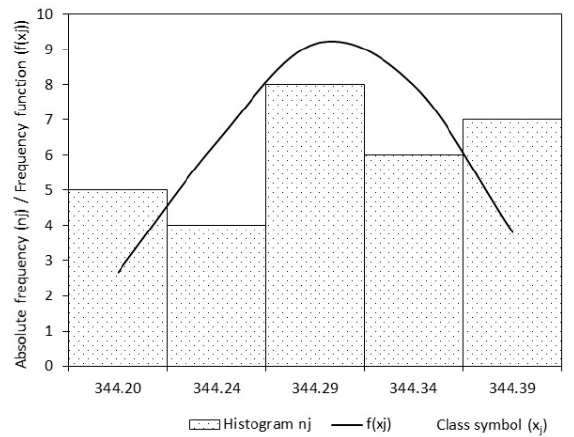
Figure 15. Histogram and frequency function for the length parameter, first day [20].